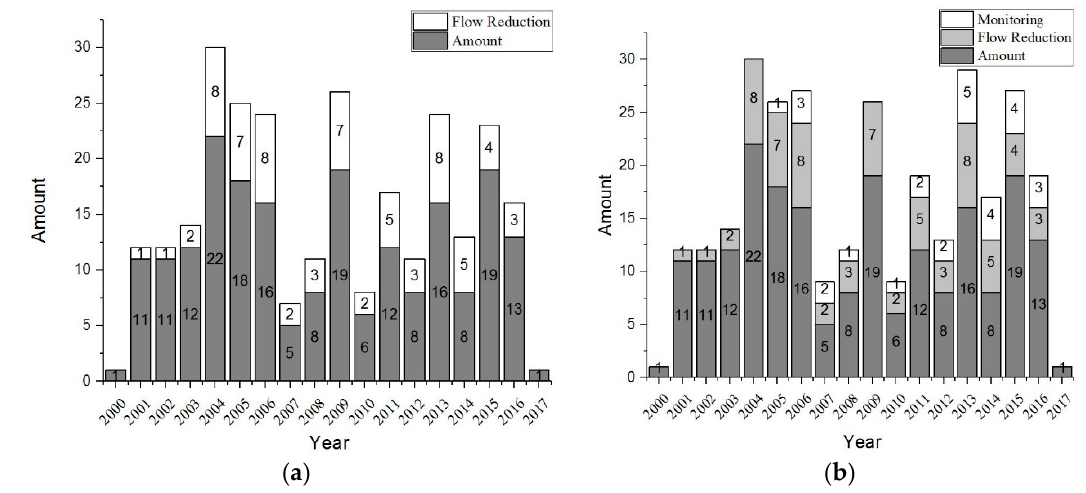
Figure 3. ( a ) Temporal distribution of projects caused flow reduction in China for 2000 to 2017; ( b ) temporal distribution of projects caused flow reduction with ecological flow monitoring. Table 2. The number of water storage and hydropower projects that caused flow reductions in rivers. Engineering Type